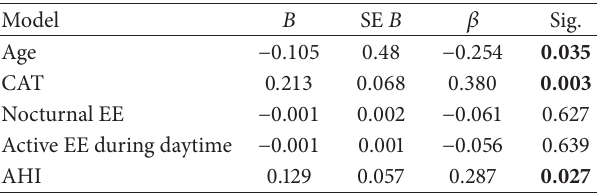
Table 3: Forced-entry multiple linear regression, outcome variable = ESS (pts) ( 𝑛 = 62